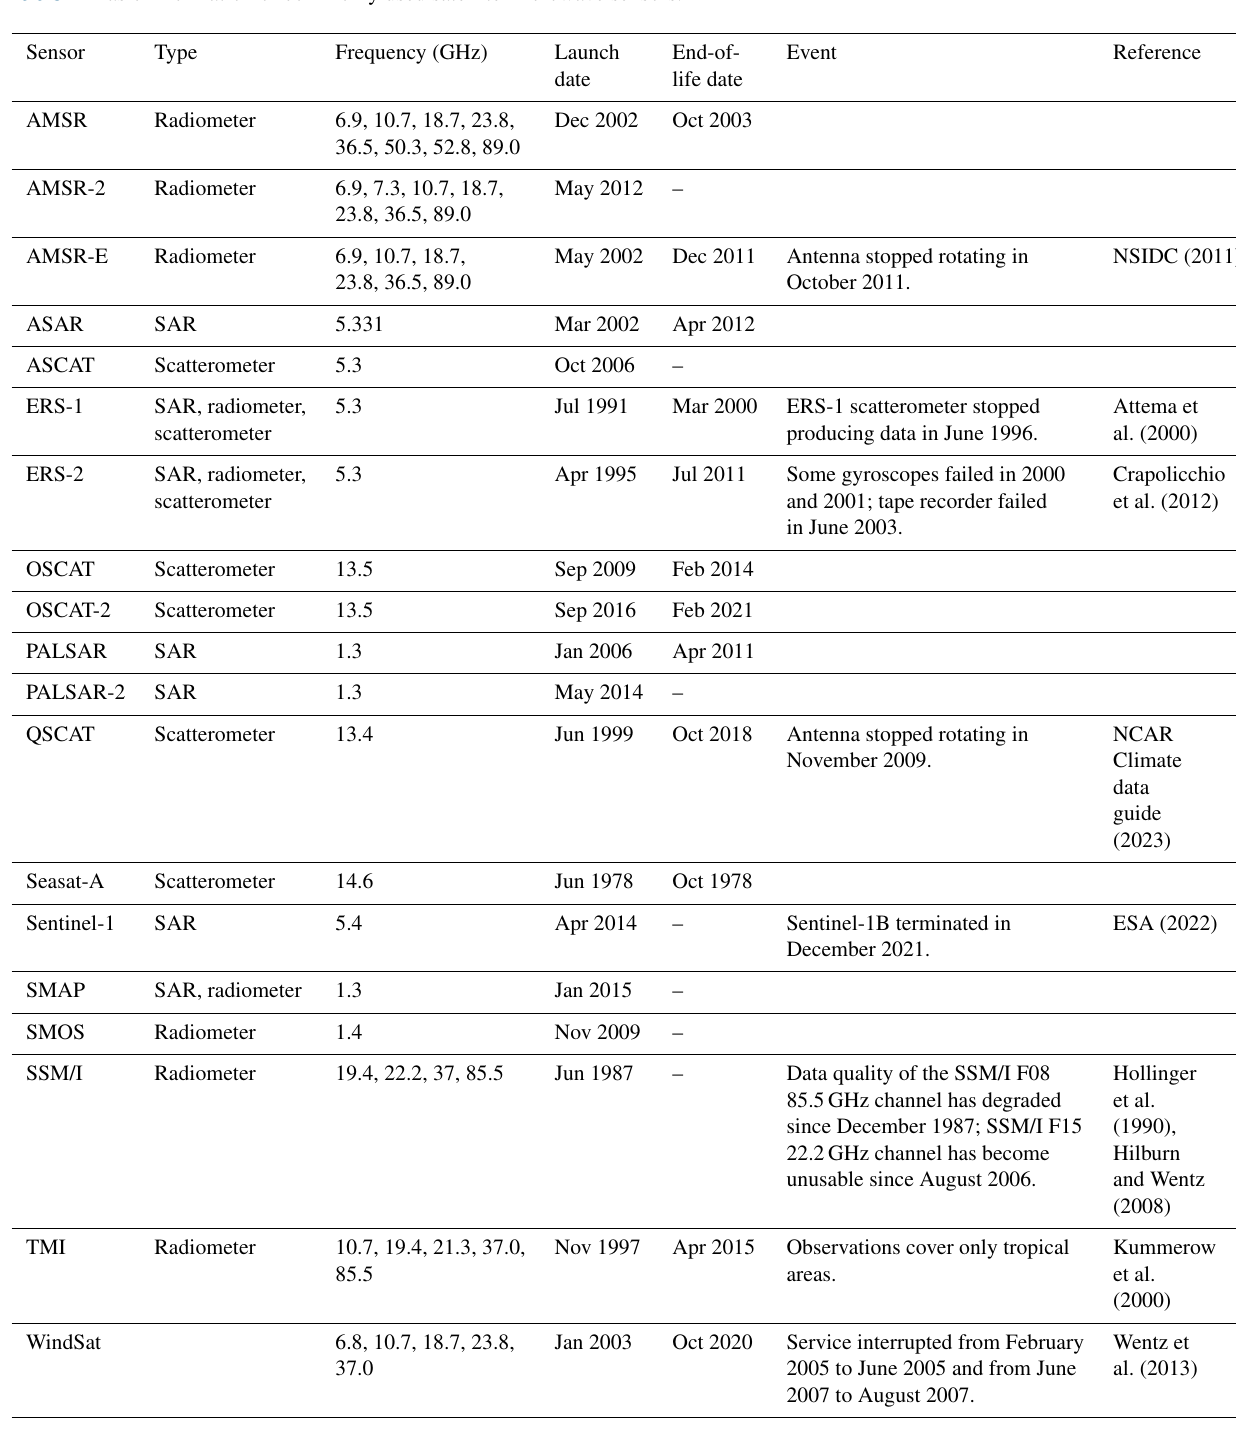
Table 1. Basic information of commonly used satellite microwave